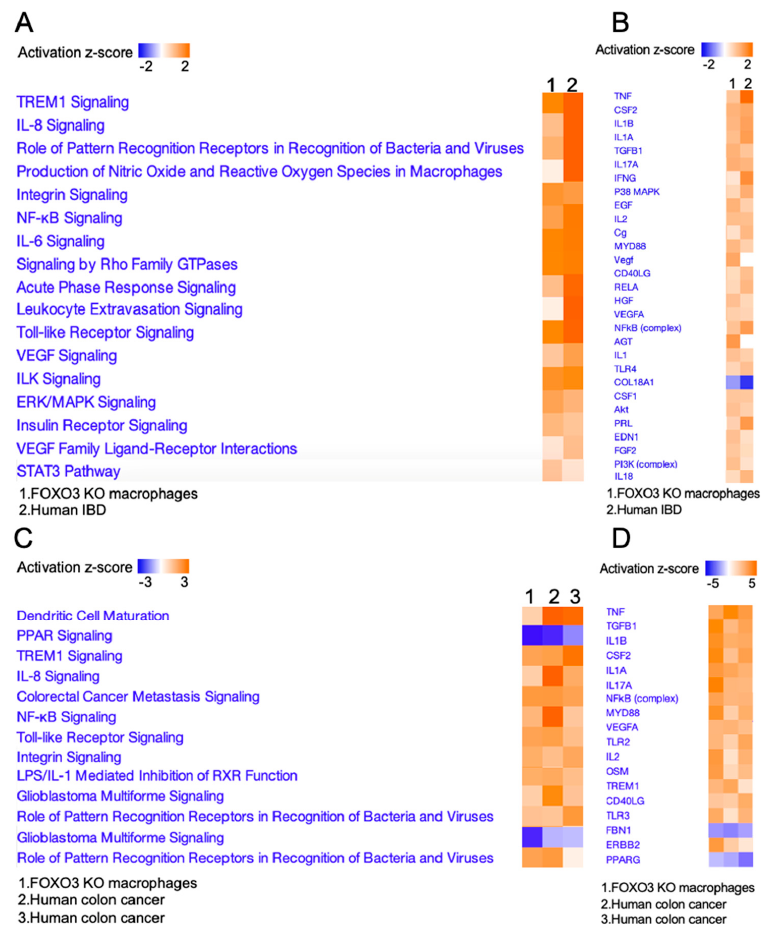
Figure 3. Transcriptome of FOXO3-deficient macrophages is significantly prevalent in IBD and human colon cancer. ( A , B ) Similar pathways and upstream regulators associated with DEGs representing FOXO3 deficient macrophages and IBD ( n = 23, GSE4183, p < 0.05, IPA). ( C , D ) Similar pathways and upstream regulators associated with DEGs representing FOXO3-deficient macrophages and human colon cancer relative to normal colon ( n = 29, GSE4183, GSE141174, p < 0.05, IPA).